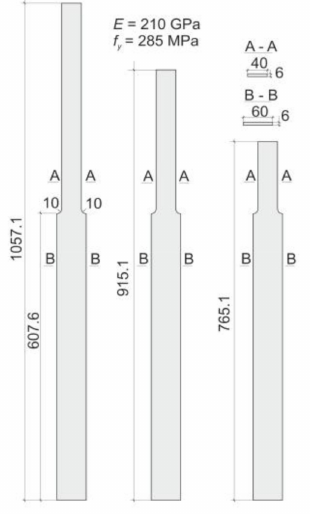
Figure 5. Columns modeled numerically.